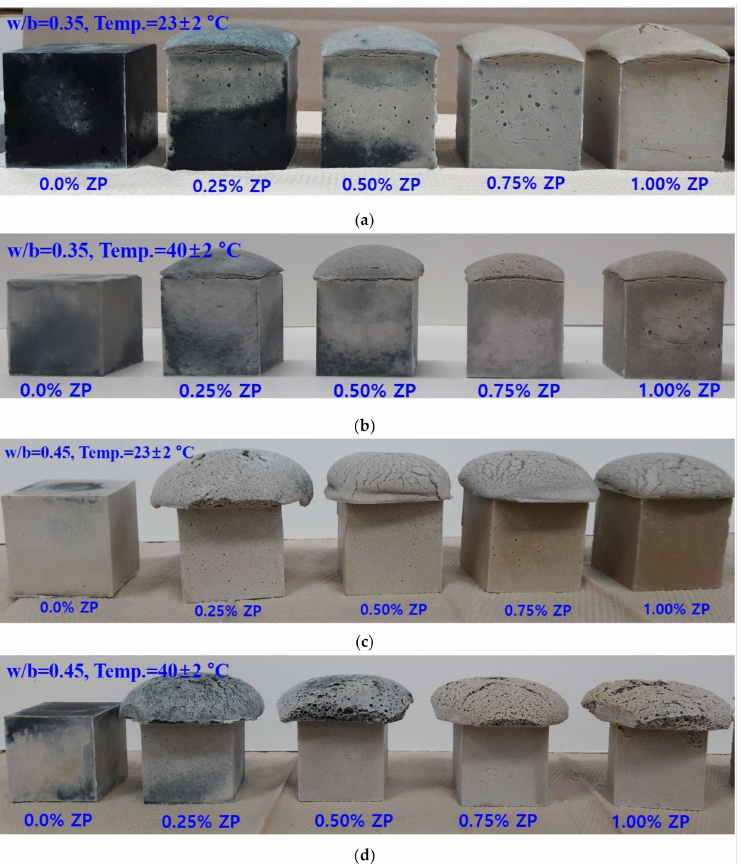
Figure 2. Sample appearances (after 24-h curing) of specimens with ( a ) w/b of 0.35, cured at 23 ± 2 ◦ C, ( b ) w/b of 0.35, cured at 40 ± 2 ◦ C, ( c ) w/b of 0.45, cured at 23 ± 2 ◦ C, and ( d ) w/b of 0.45, cured at 40 ± 2 ◦